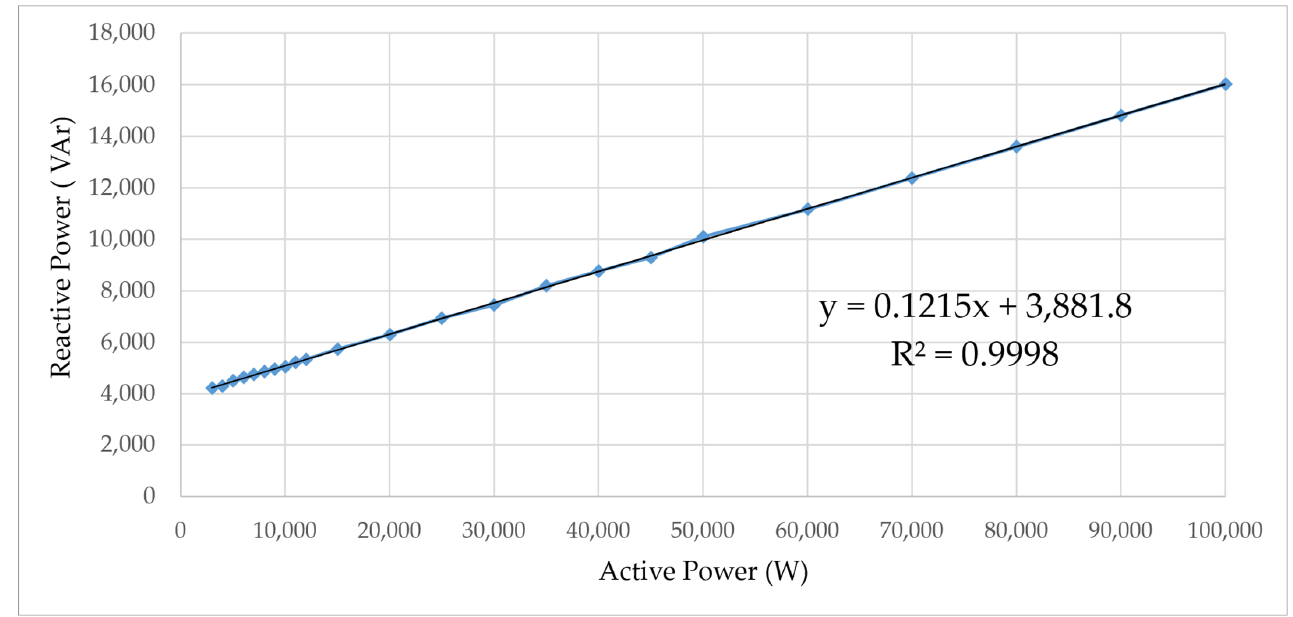
Figure 20. Active and reactive power relationships result—ratio PxQ, frequency: 50 Hz. Table 4. Comparison between Centralized Control and Decentralized Control. Time delay